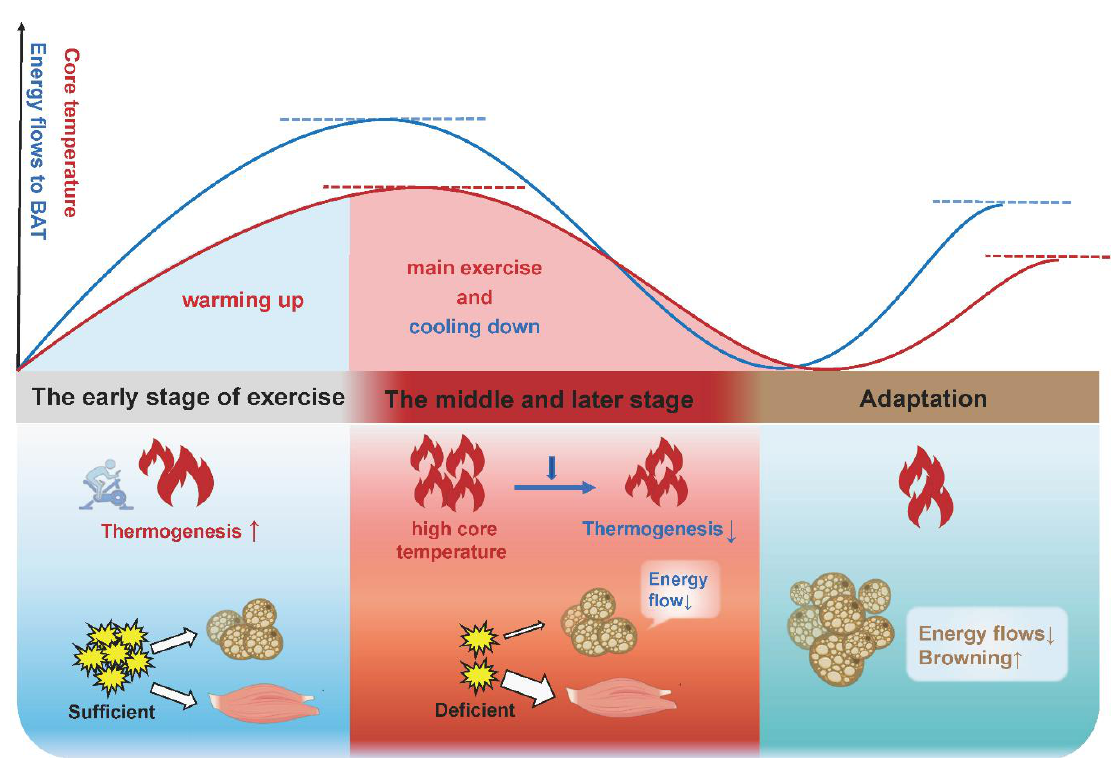
Figure 4. The physiological significance of adipose tissue thermogenesis and browning in different stages of exercise adaptation. In the early stage of acute exercise and long-term exercise, BAT increases thermogenesis to expend energy and raise the core temperature, which accelerates the body to adapt to exercise (warming up). In the late stage of acute exercise with an increased core temperature and depleted energy substrates, or in the late stage of long-term exercise training with the saving of energy substrates, BAT thermogenesis will be gradually lowered (cooling down). Beige adipose tissue is more responsive to ex- ercise and more suitable for exercise, due to its greater oxidative capacity and more active metabolism. Thus, the increased adipose tissue browning is an adaptation upon exercise stimulation.